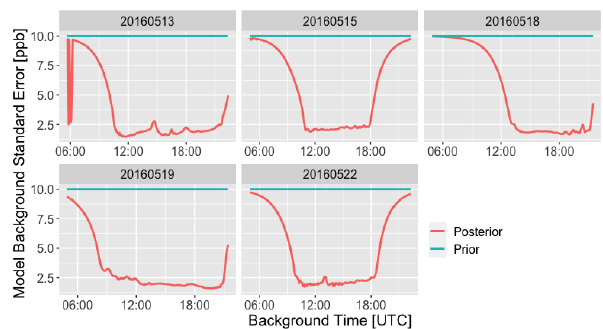
Figure 14. Posterior values for modeled background standard error.